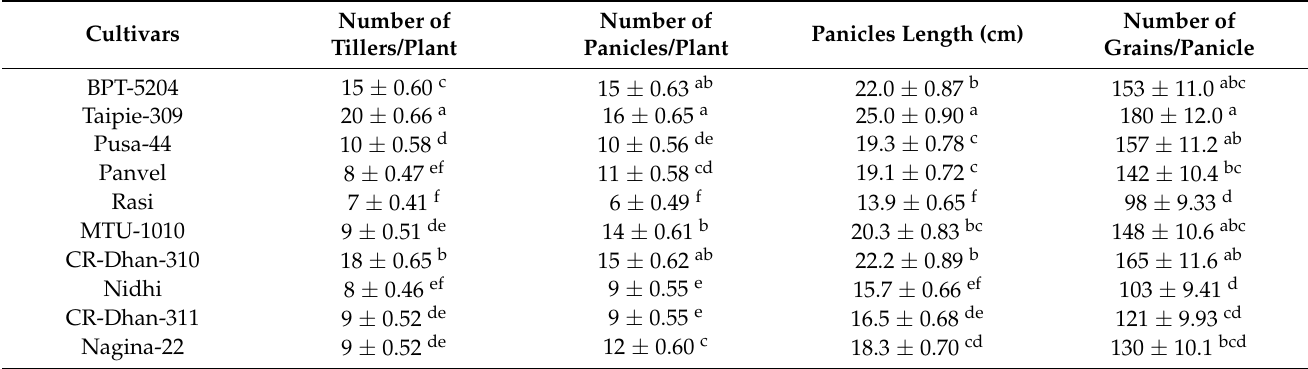
Table 3. Number of tillers per plant, number of panicles per plant, panicles length, and number of grains per panicle in cultivars of rice ( Oryza sativa L.) at